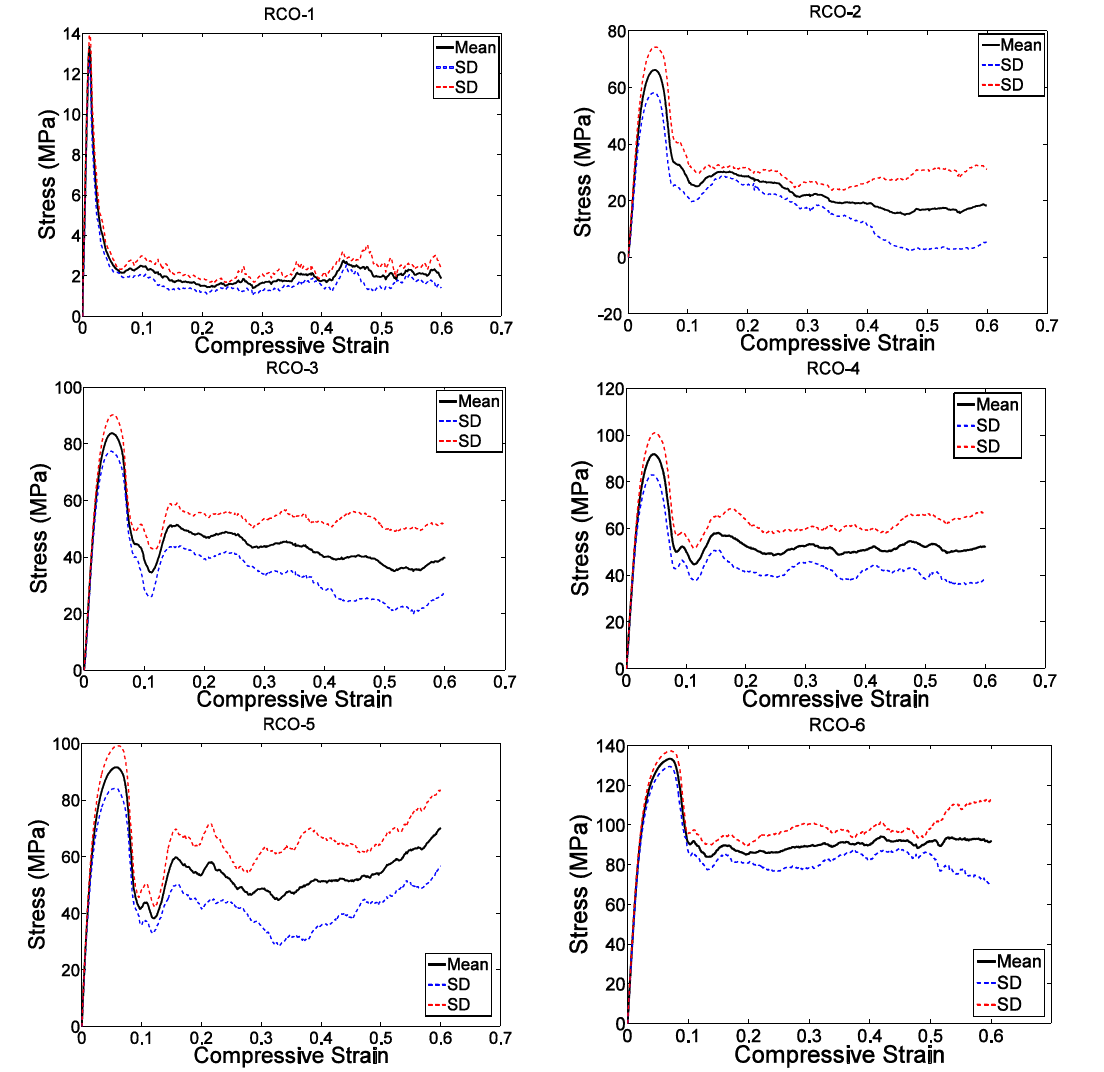
Figure 8. Compressive stress- versus -compressive strain curves for specimens based on the rhombicuboctahedron unit cell and with different porosities (see Table